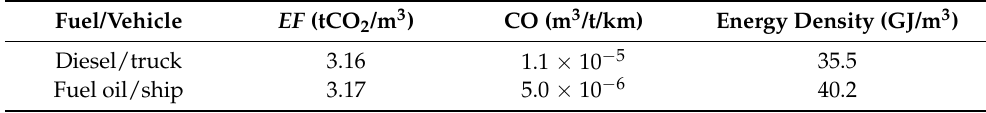
Table 4. CO 2 emission factors and energy density for each